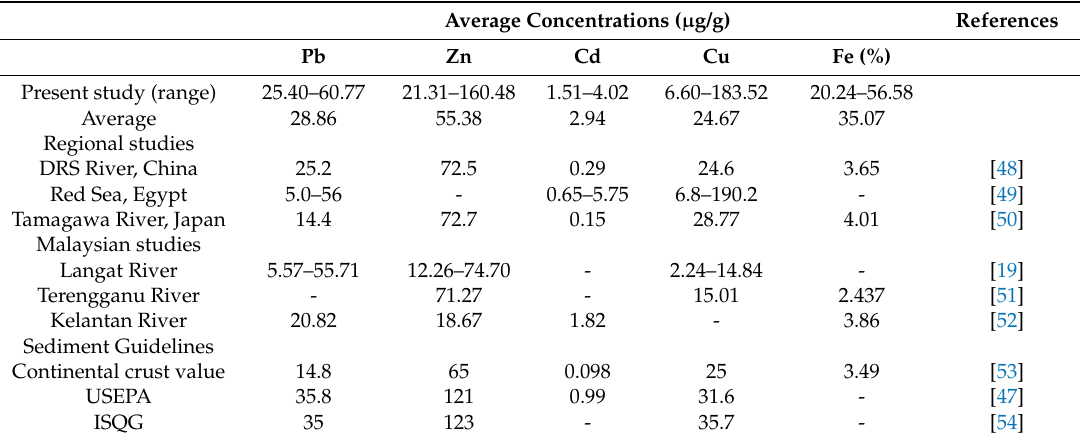
Table 4. Comparison of observed result with sediment guidelines and previous study.